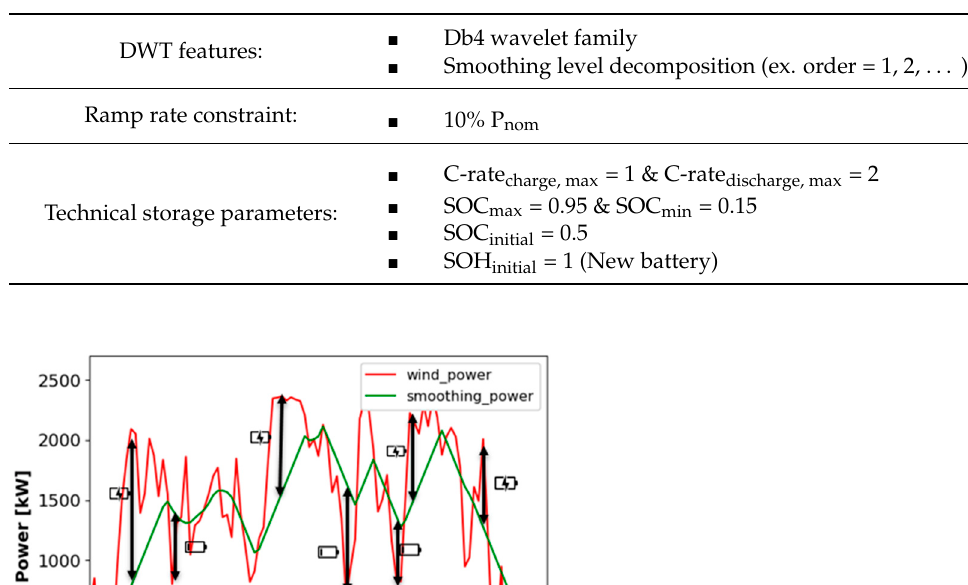
Table 2. Smoothing algorithm inputs.